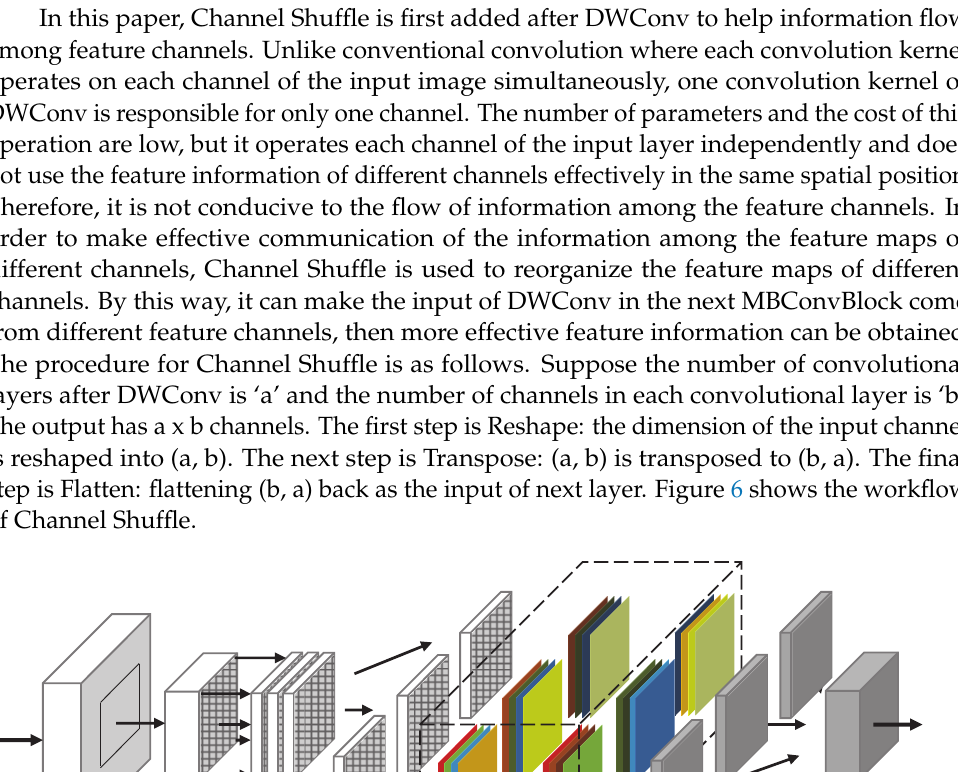
Figure 5. The structure of Reconstructed MBConvBlock. BN is the BatchNorm. Swish is an activation function. Global Average Pooling (GAP) is used to obtain the global spatial information of the feature map.